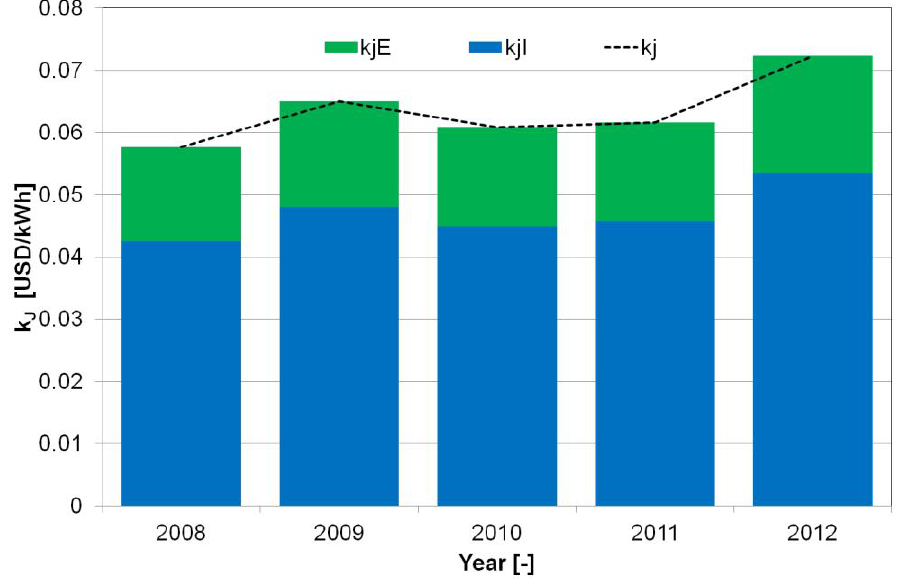
Figure 4. Value of discounted unit cost k j of energy generation in an optimised WPP system without energy storage.